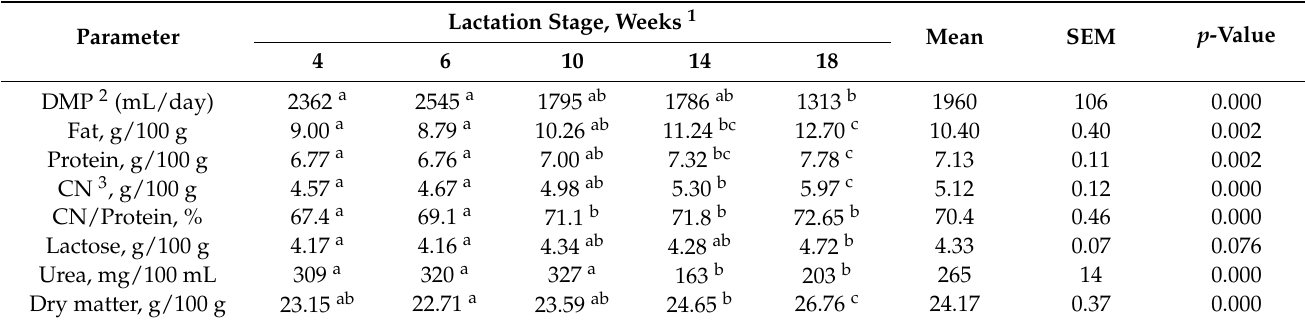
Table 1. Milk production and composition of red deer milk collected over the 18-week lactation period.